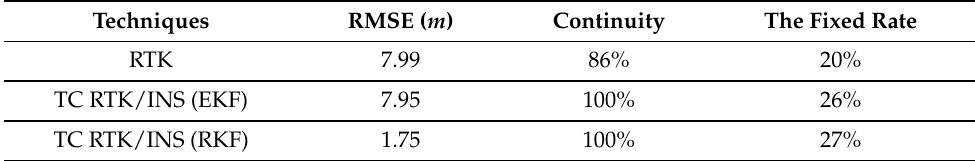
Figure 11. The box plots show comparison between the integration with and without the outlier resistance. Table 4. The positioning performance comparison (Odaiba).